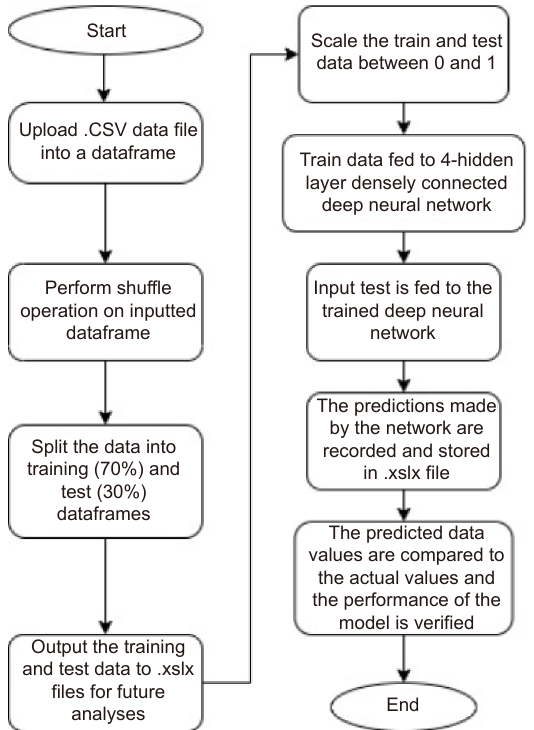
Fig. 12 | Flowchart for deep learning